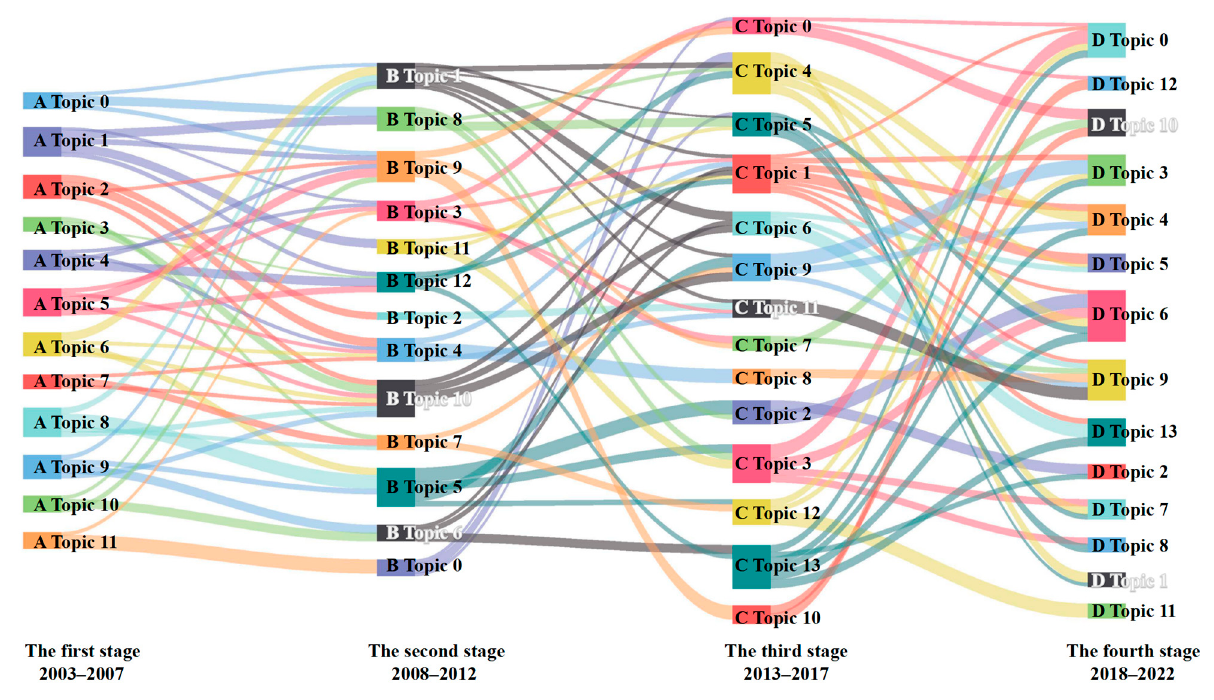
Figure 5. CCUS patent topic evolution river diagram.